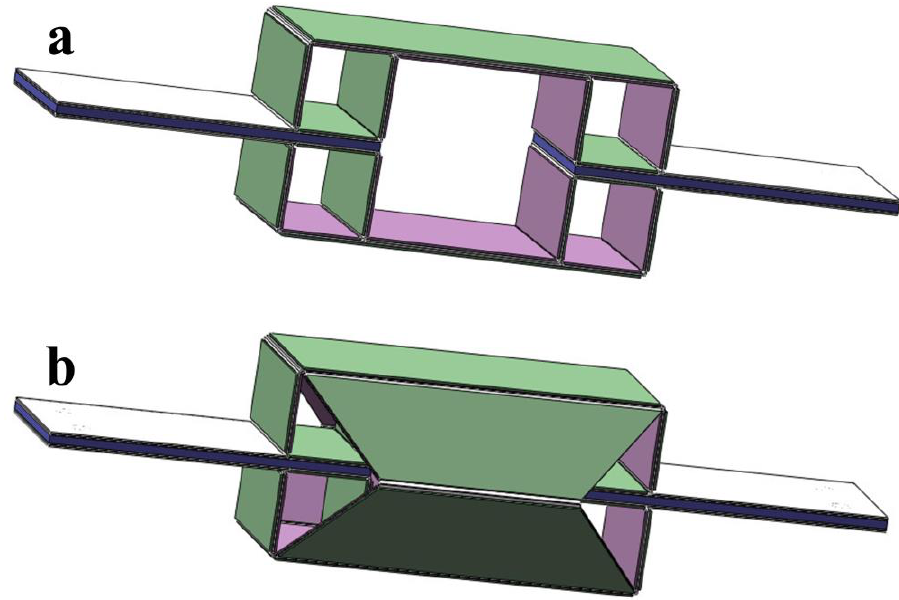
Figure 2. Origami-inspired 3D folding structures: ( a ) Initial configuration; ( b ) Improved configuration with side support.